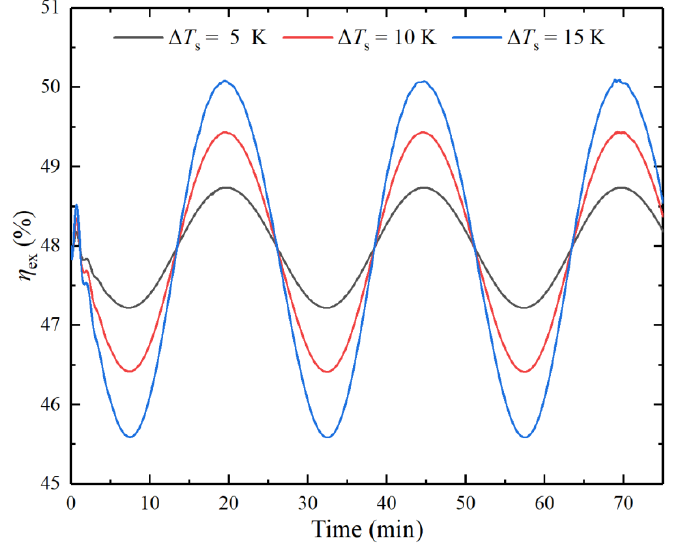
Figure 10. Effect of heat-source temperature on exergy efficiency.